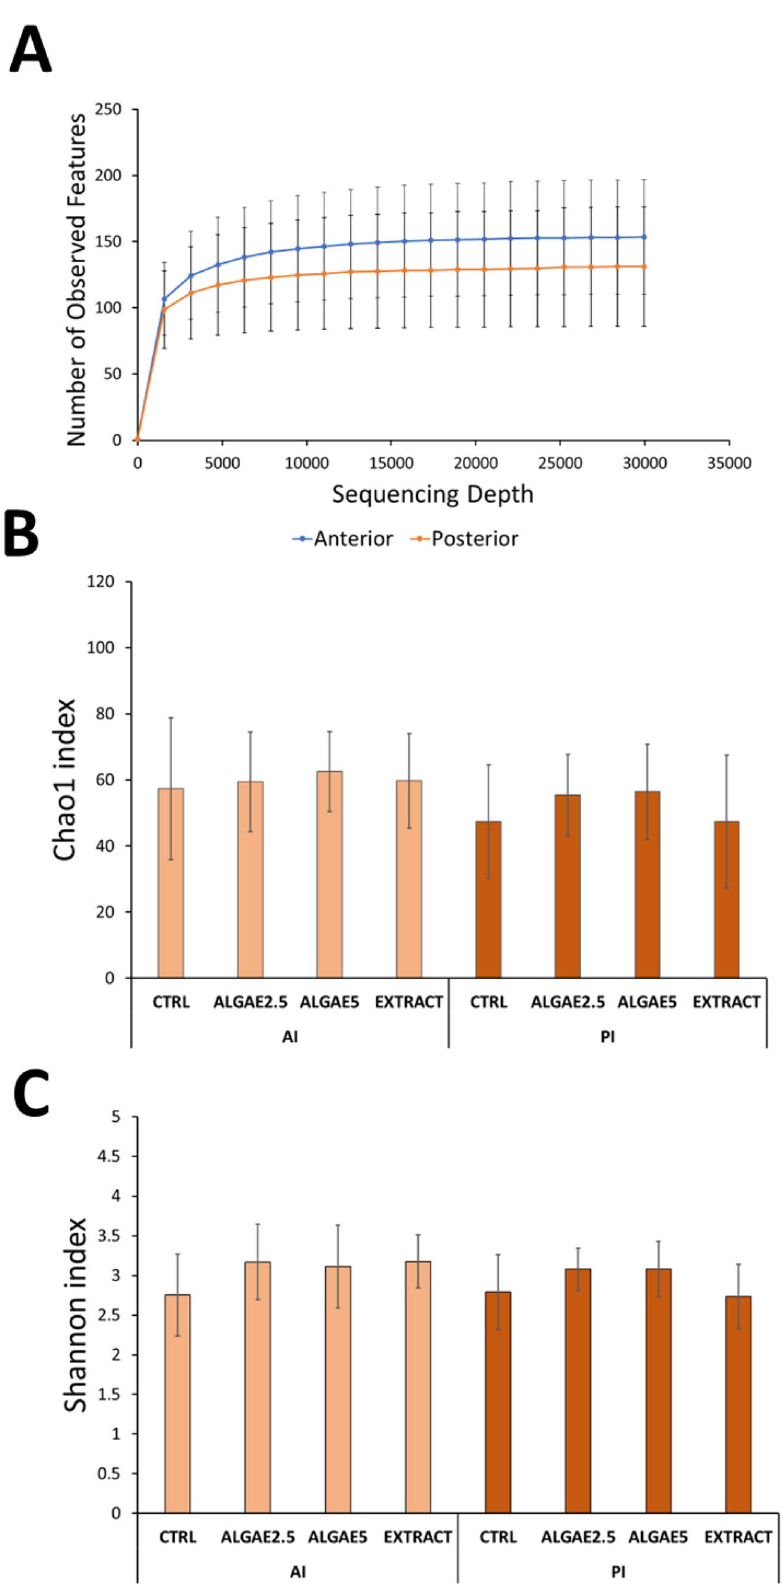
Figure 1. Rarefaction curve ( A ), chao1 richness index ( B ) and Shannon diversity index ( C ) of European seabass gut microbial communities for anterior and posterior intestine. Rarefaction curve indicates number of observed features for anterior (blue) and posterior (orange) intestine depending on sequencing depth. Fish were fed a basal diet with no supplement (CTRL) or supplemented with Gracilaria gracilis powdered biomass at 2.5% (ALGAE2.5), at 5% (ALGAE5) or with the seaweed extract at 0.35% inclusion rate (EXTRACT). No significance differences were observed; dots (in A) and bars (in B and C ) indicate mean value of the group and error lines indicate ± SD; AI and PI stand for anterior and posterior intestine respectively (Kruskall–Wallis, P >